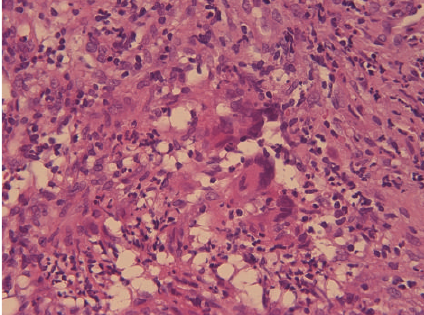
Figure 2: Nasal biopsy showing numerous multinucleated giant cells (haematoxylin-eosin staining).